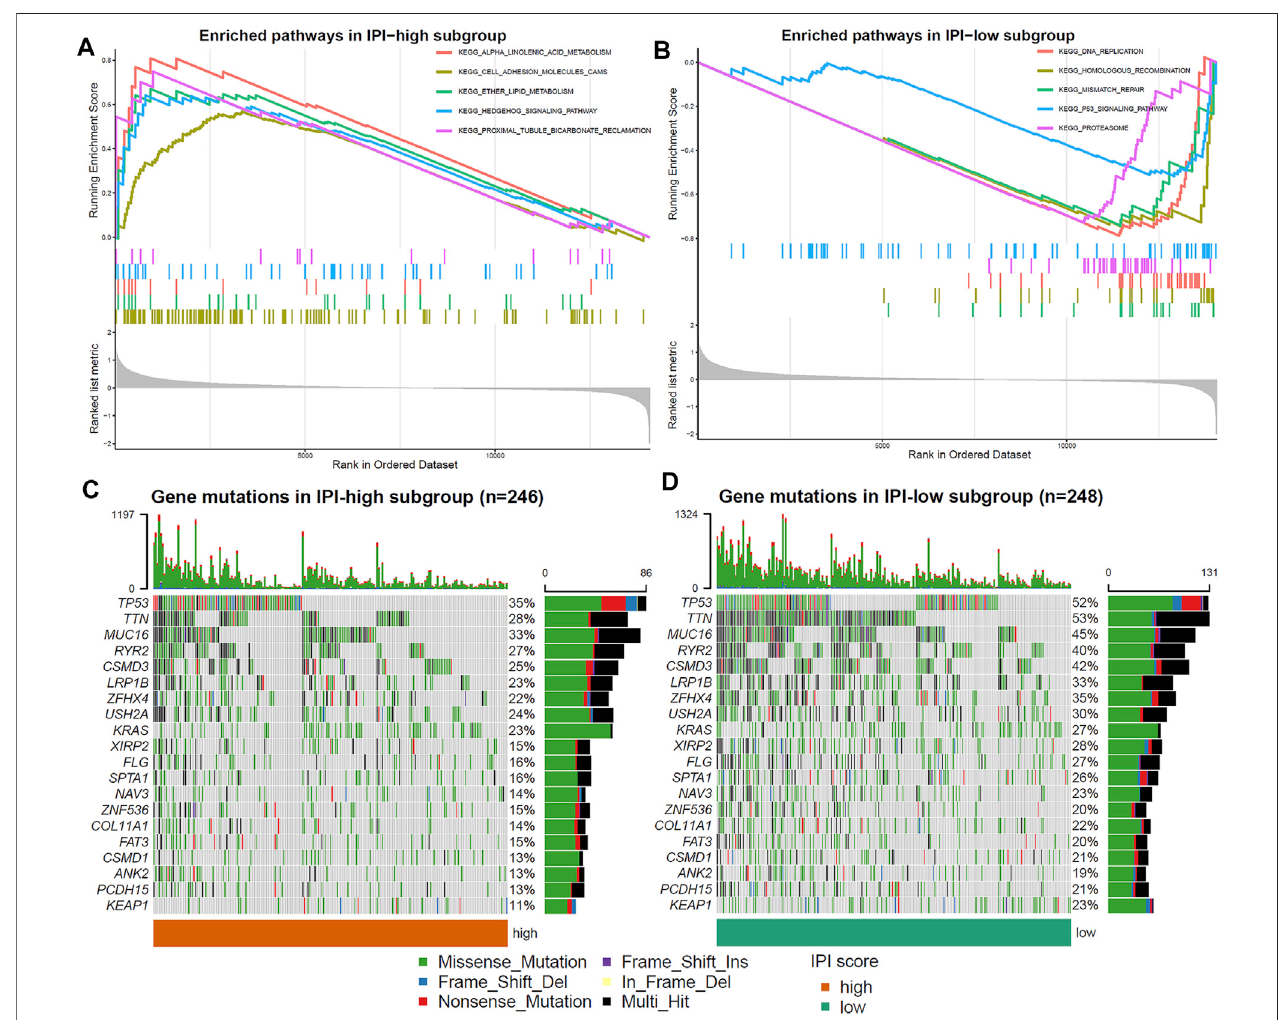
FIGURE 3 | Molecular characteristics of IPI subgroups. (A,B) Enriched pathways in IPI-high and IPI-low subgroups ( p < 0.05, FDR < 0.25). (C,D) Top 20 gene mutations in IPI-high and IPI-low subgroups. The percentage of mutations is shown on the right and the total number of mutations on the top. Different colors represent different types of